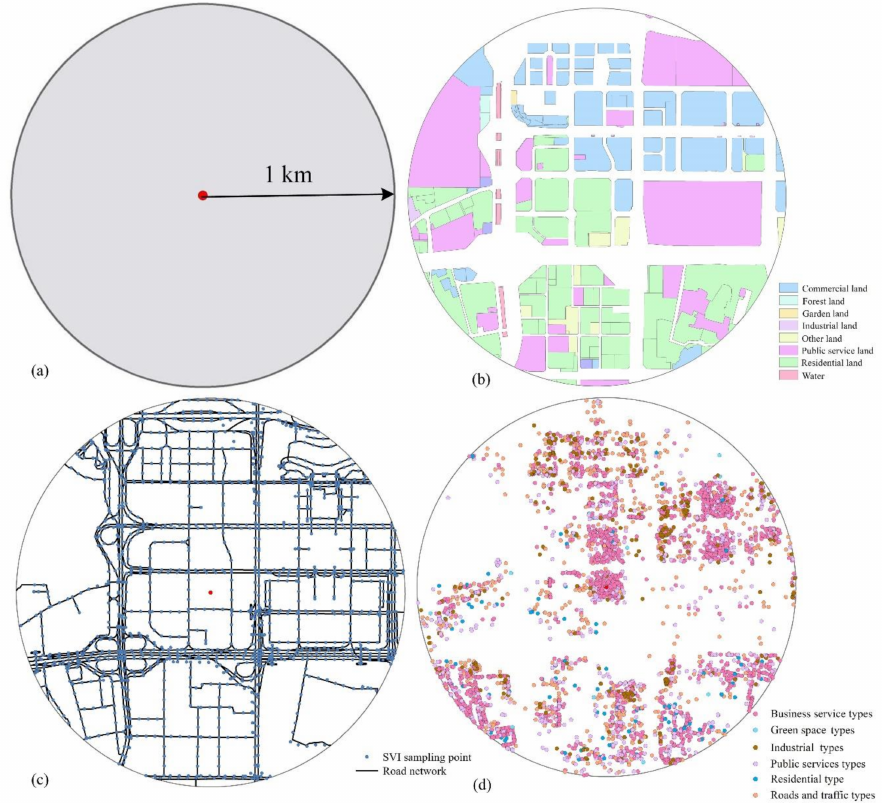
Figure 3. Examples of the data used to calculate influential factors for housing prices: ( a ) community location and 1 km buffer area; ( b ) land-use data in buffer area of sample; ( c ) road network and street view sampling points in buffer area; and ( d ) POI data in buffer area of sample.